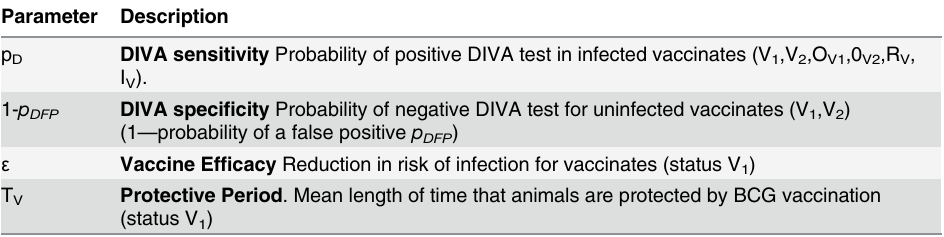
Table 10. Vaccination model